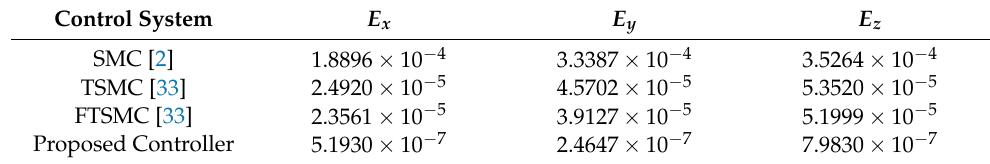
Table 4. RMS error with investigation time ranges from 6 s → 20 s via four